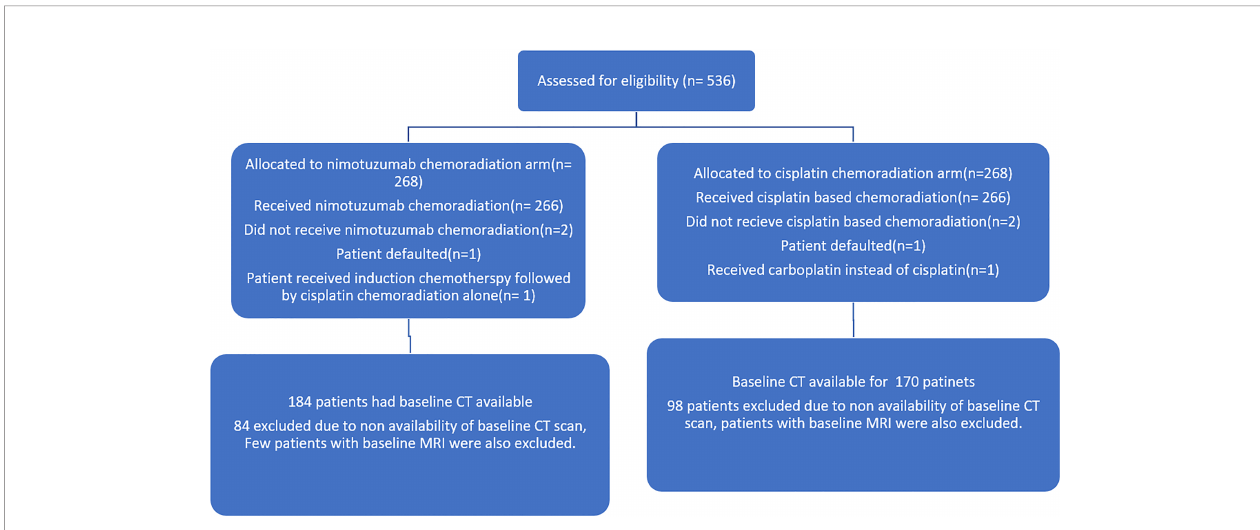
FIGURE 1 | Consort diagram of the nimotuzumab plus cisplatin-chemoradiation arm versus cisplatin-chemoradiation arm showing the patient